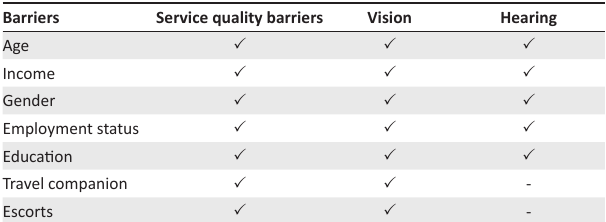
TABLE 5: Summary of socio-demographic barriers.